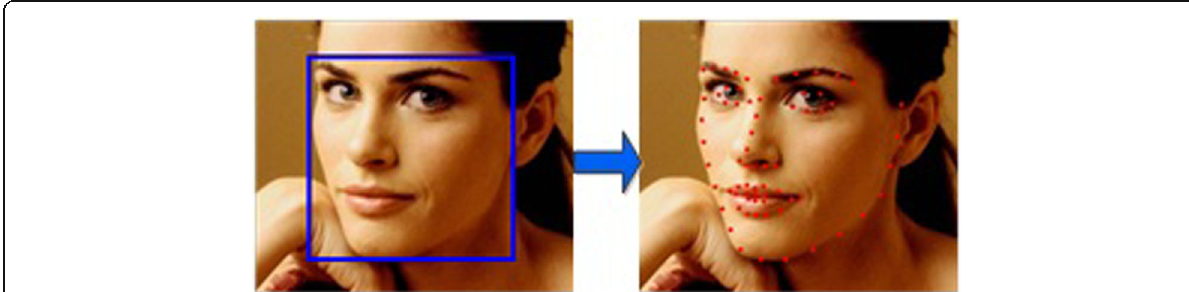
Fig. 17 The picture of side face